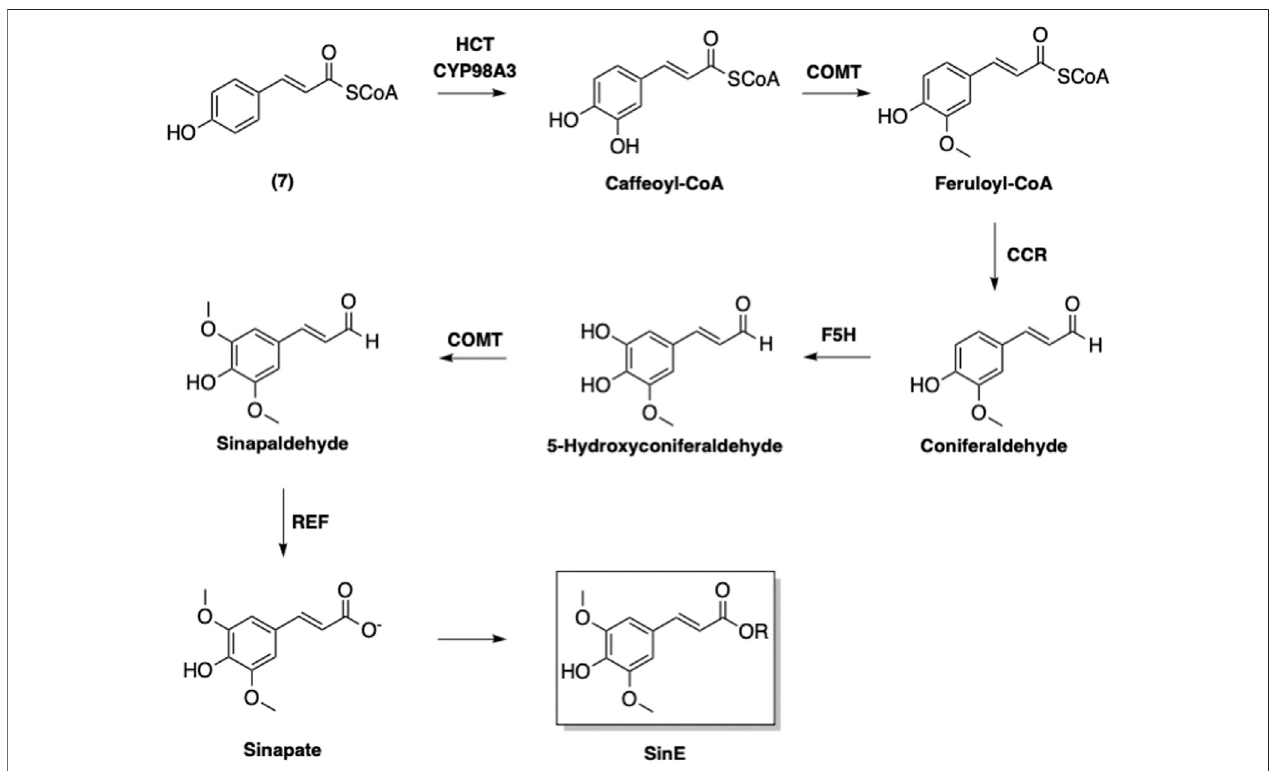
FIGURE 7 | Biosynthesis of sinapoyl esters. HCT: p -Hydroxycinnamoyl-CoA: quinate shikimate p -hydroxycinnamoyltransferase; COMT: Caffeic acid O -methyltransferase; CCR: Cinnamoyl-CoA reductase; F5H: Ferulate 5-hydroxylase; REF: Reduced Epidermal Fluorescence Aldehyde Dehydrogenase.